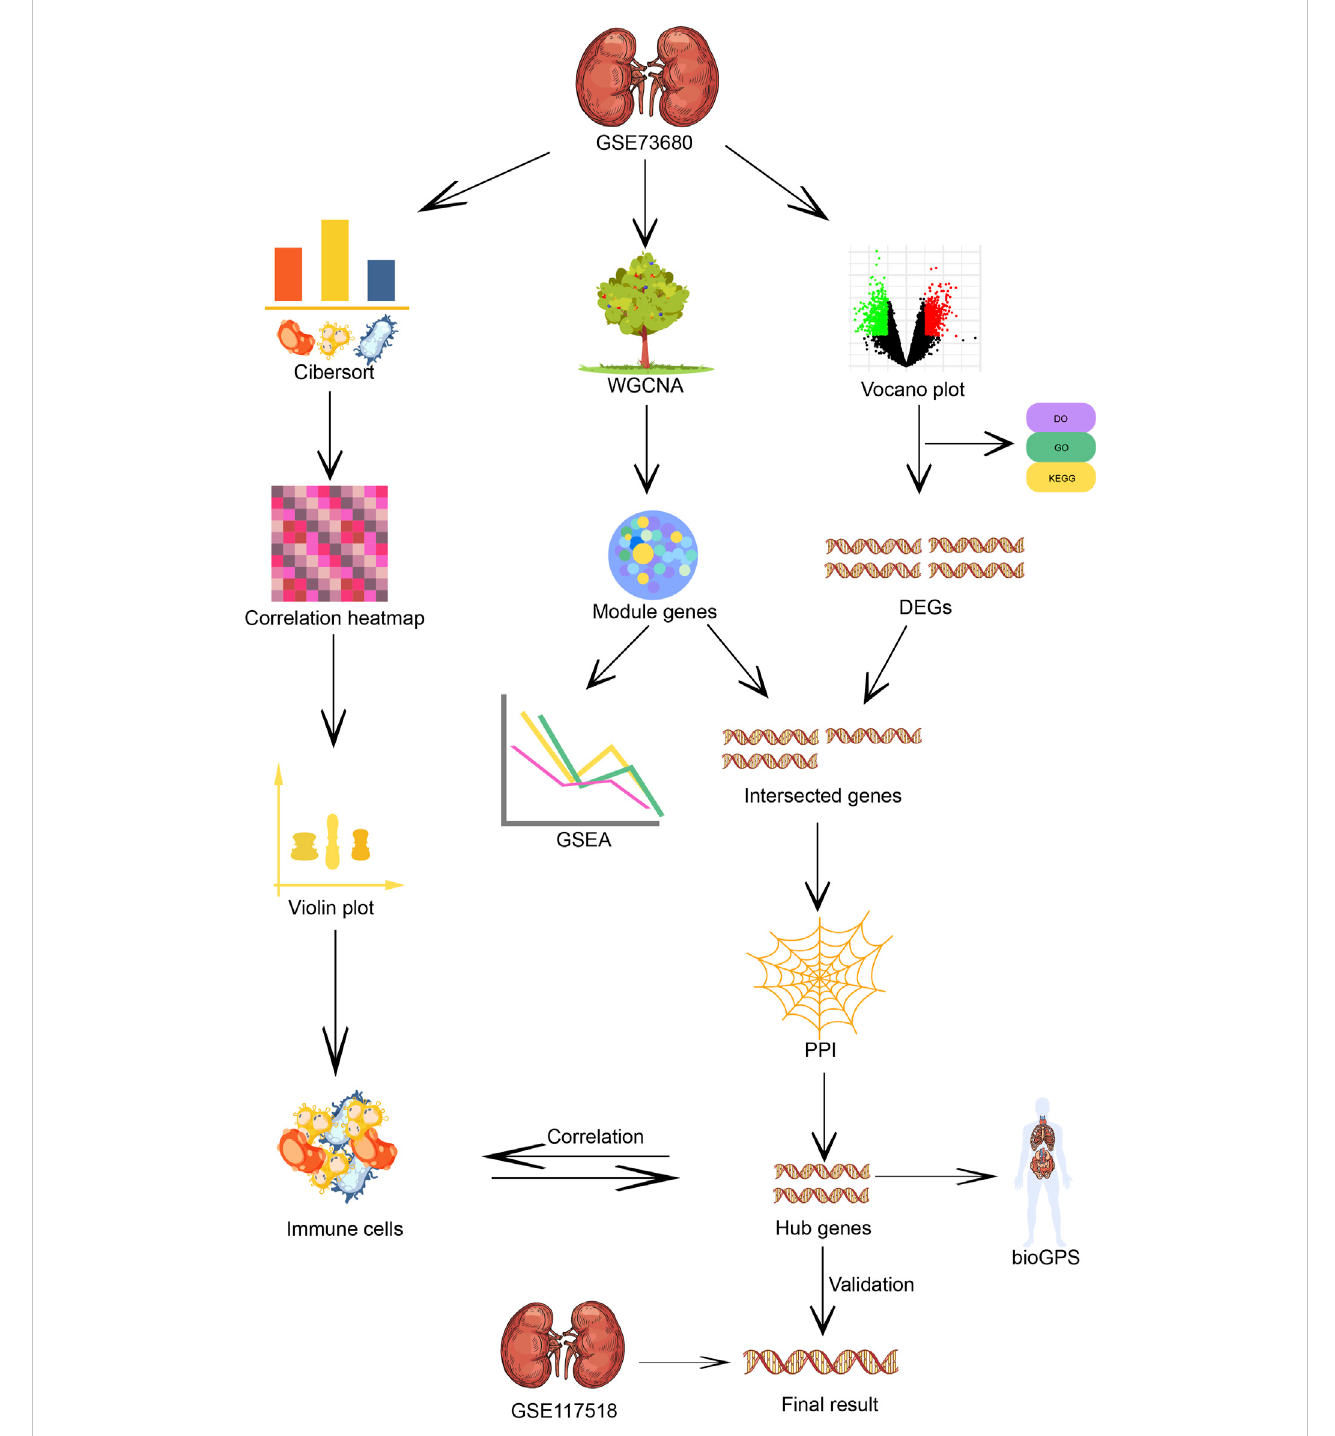
FIGURE 1 Flow chart of immune in fi ltration, WG-CNA algorithm and core genes screening of the microarray analysis process.